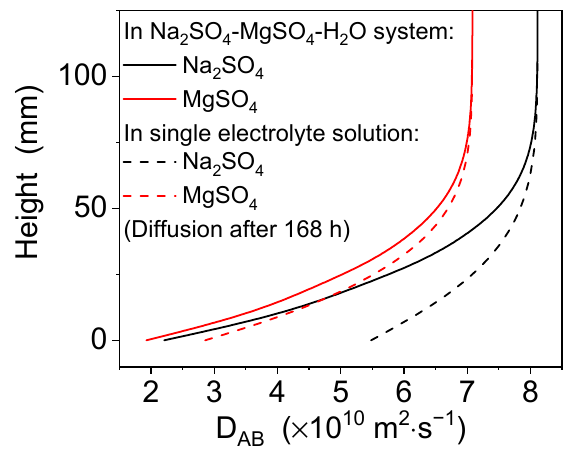
Figure 9. Comparison of mass transfer coefficients between mixed-electrolyte (Na 2 SO 4 -MgSO 4 -H 2 O system from the bloedite dissolution) and single-electrolyte systems.